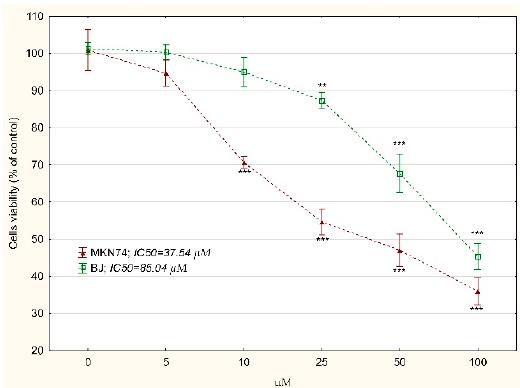
hoc analysis). IC 50 value was determined using the AAT Bioquest IC 50 calculator.